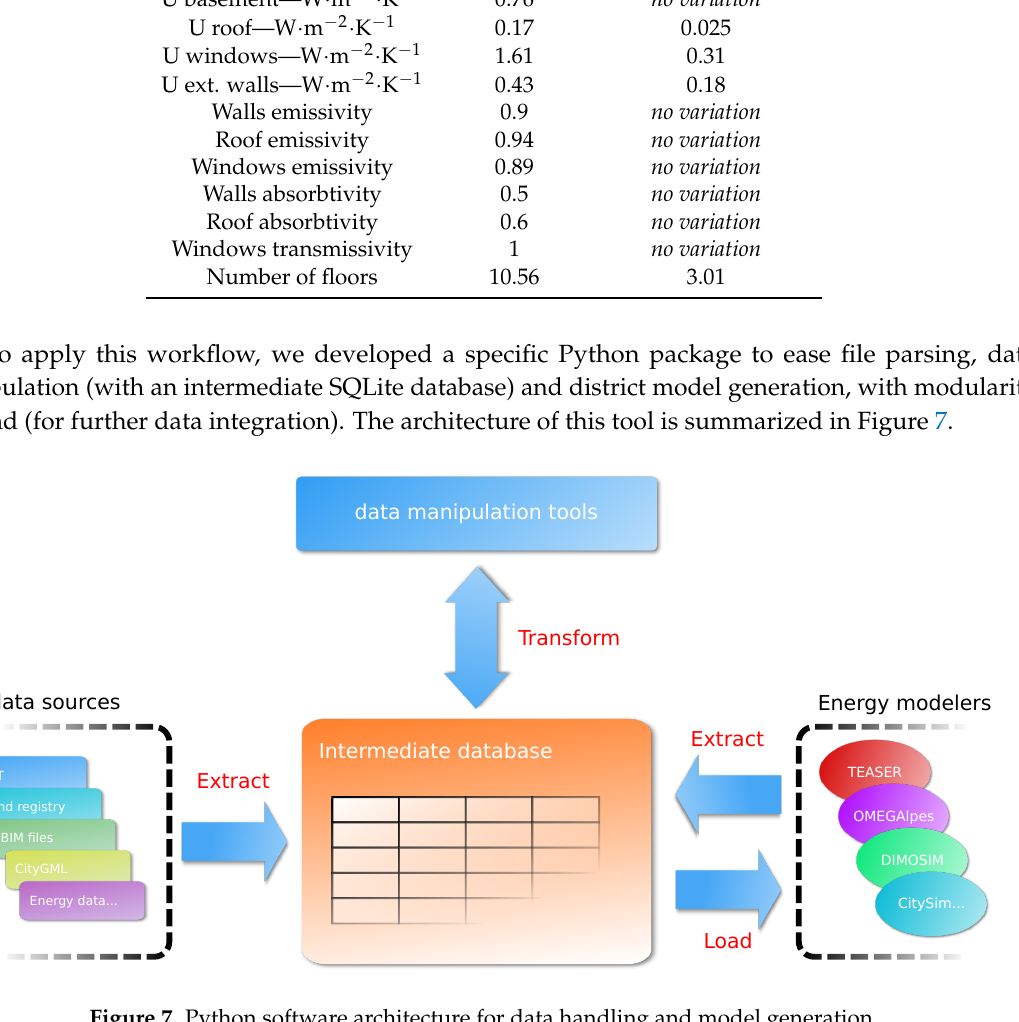
Figure 7. Python software architecture for data handling and model